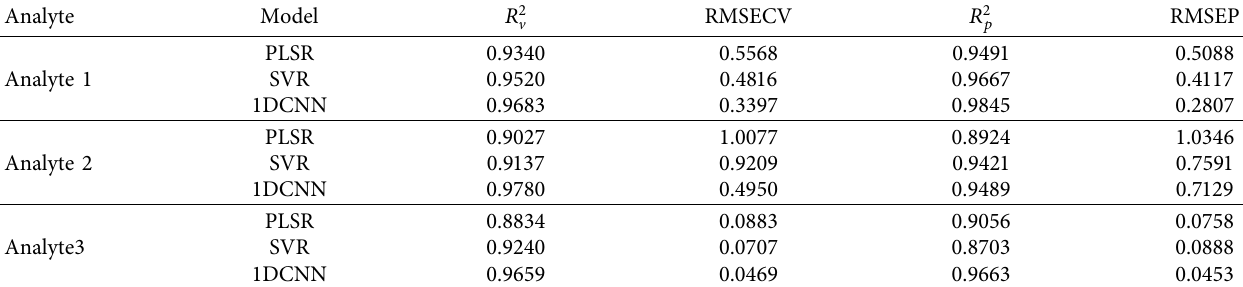
Table 2: Comparison of evaluation indices of the 1DCNN model, PLSR model, and SVR model with normal spectra. Analyte